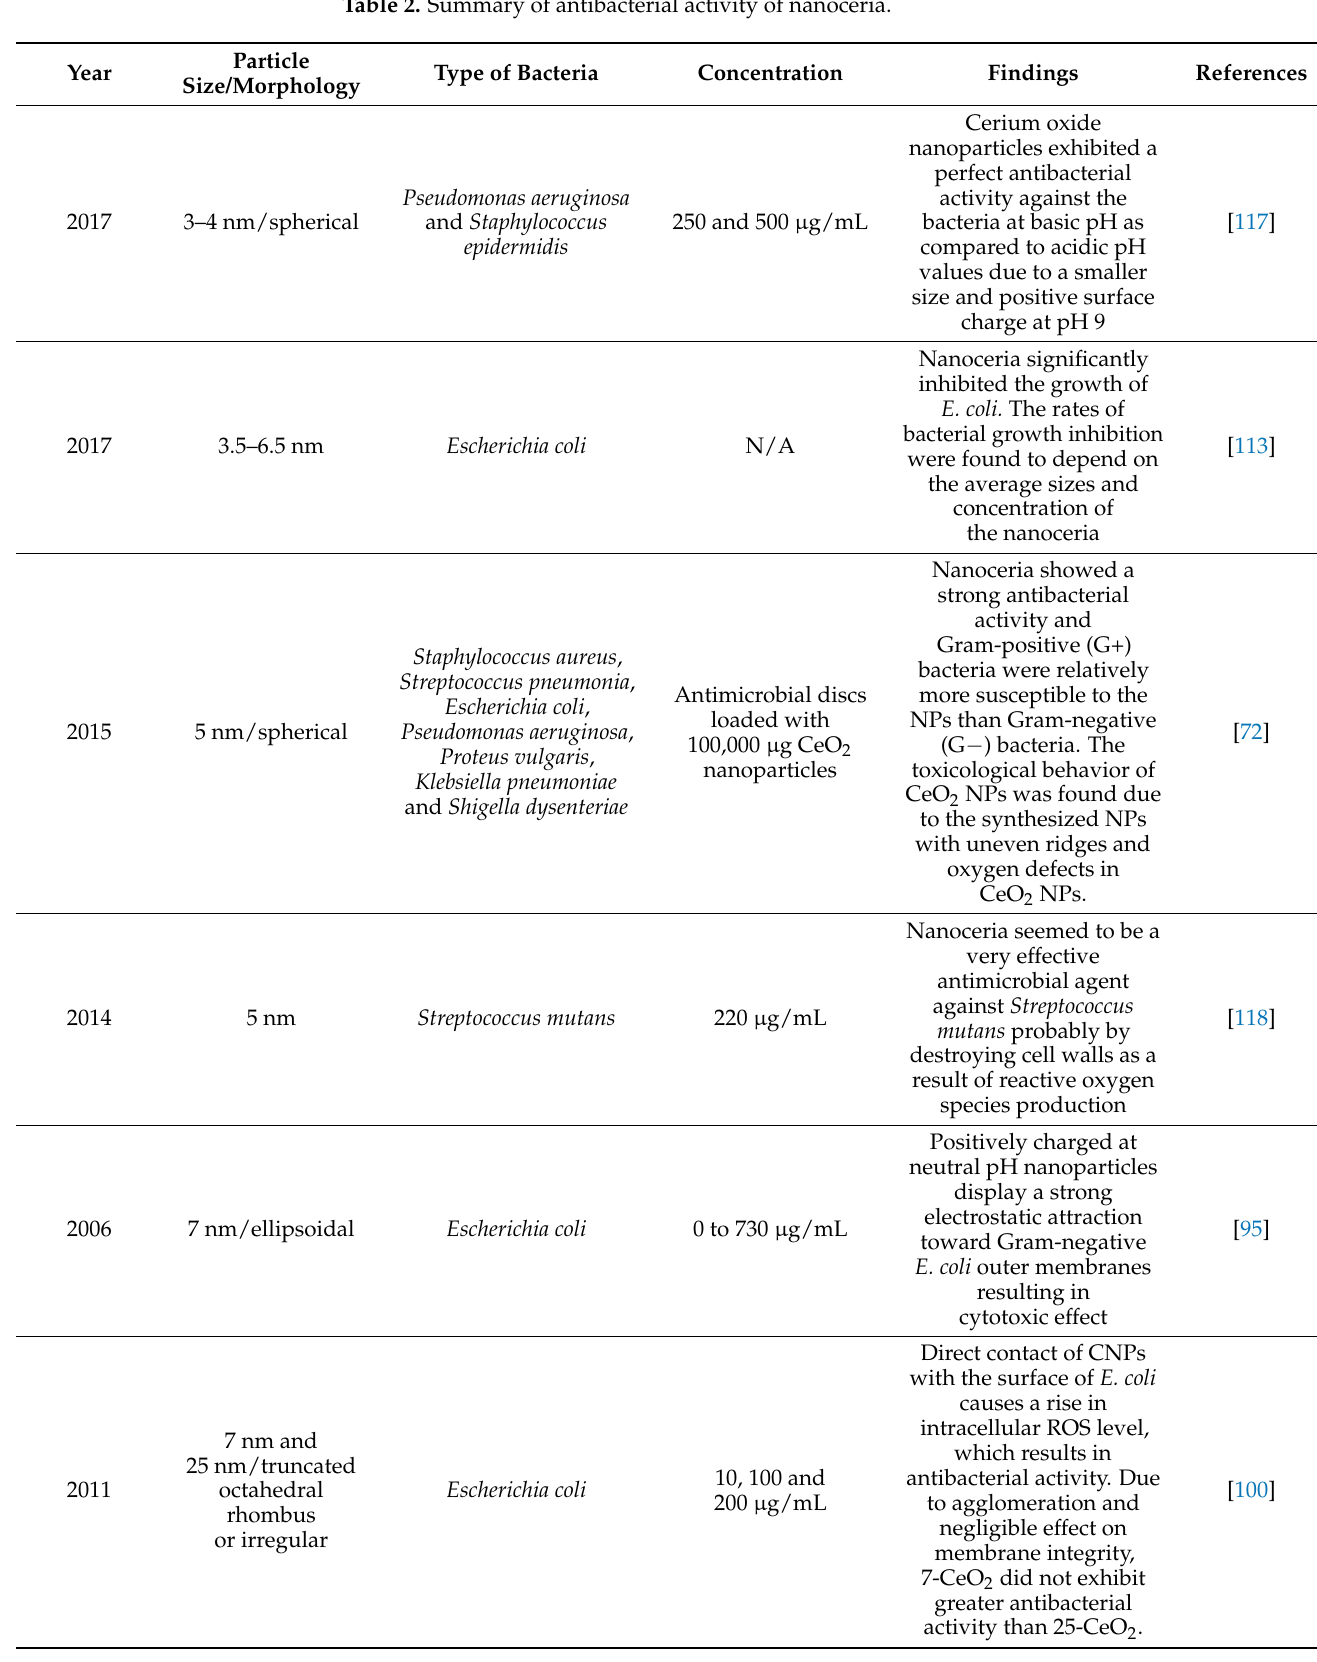
Table 2. Summary of antibacterial activity of